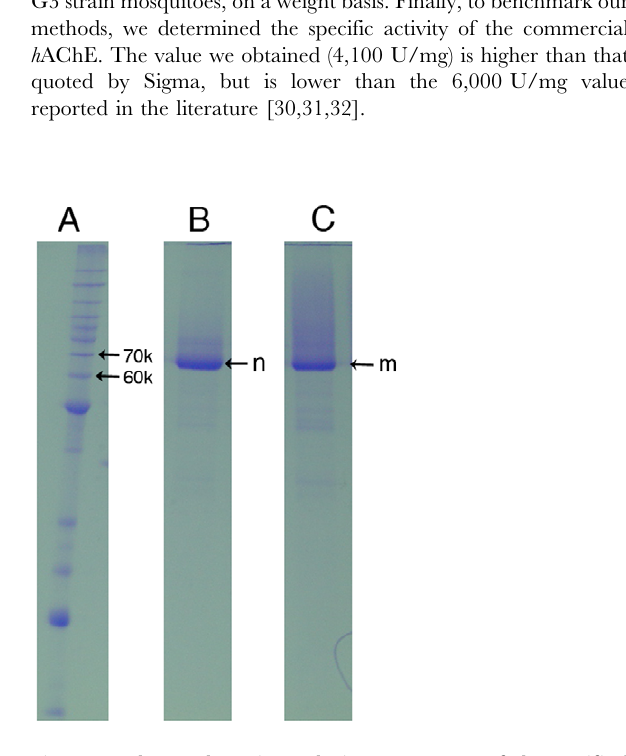
Figure 3. Electrophoretic analysis (SDS-PAGE) of the purified r Ag AChE (WT and G119S). A: Protein standard (Da); B: r Ag AChE-WT (‘‘n’’); C: r Ag AChE-G119S mutant (‘‘m’’).